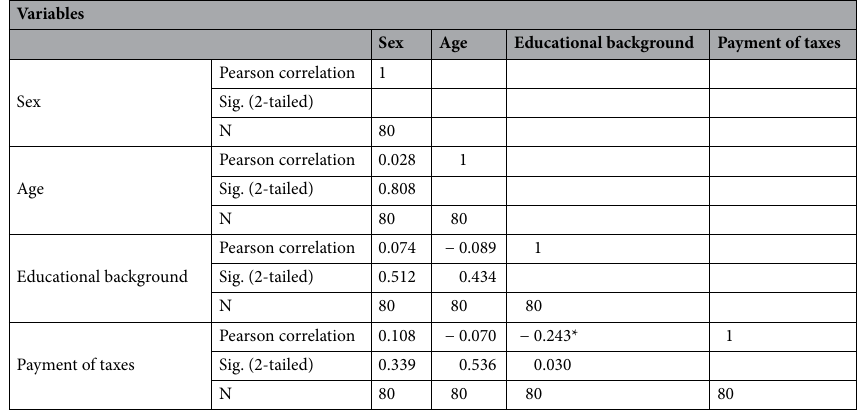
Table 5. Relationship between Sociodemographic Characteristics and Payment of Taxes. * Correlation is significant at the 0.05 level (2-tailed).